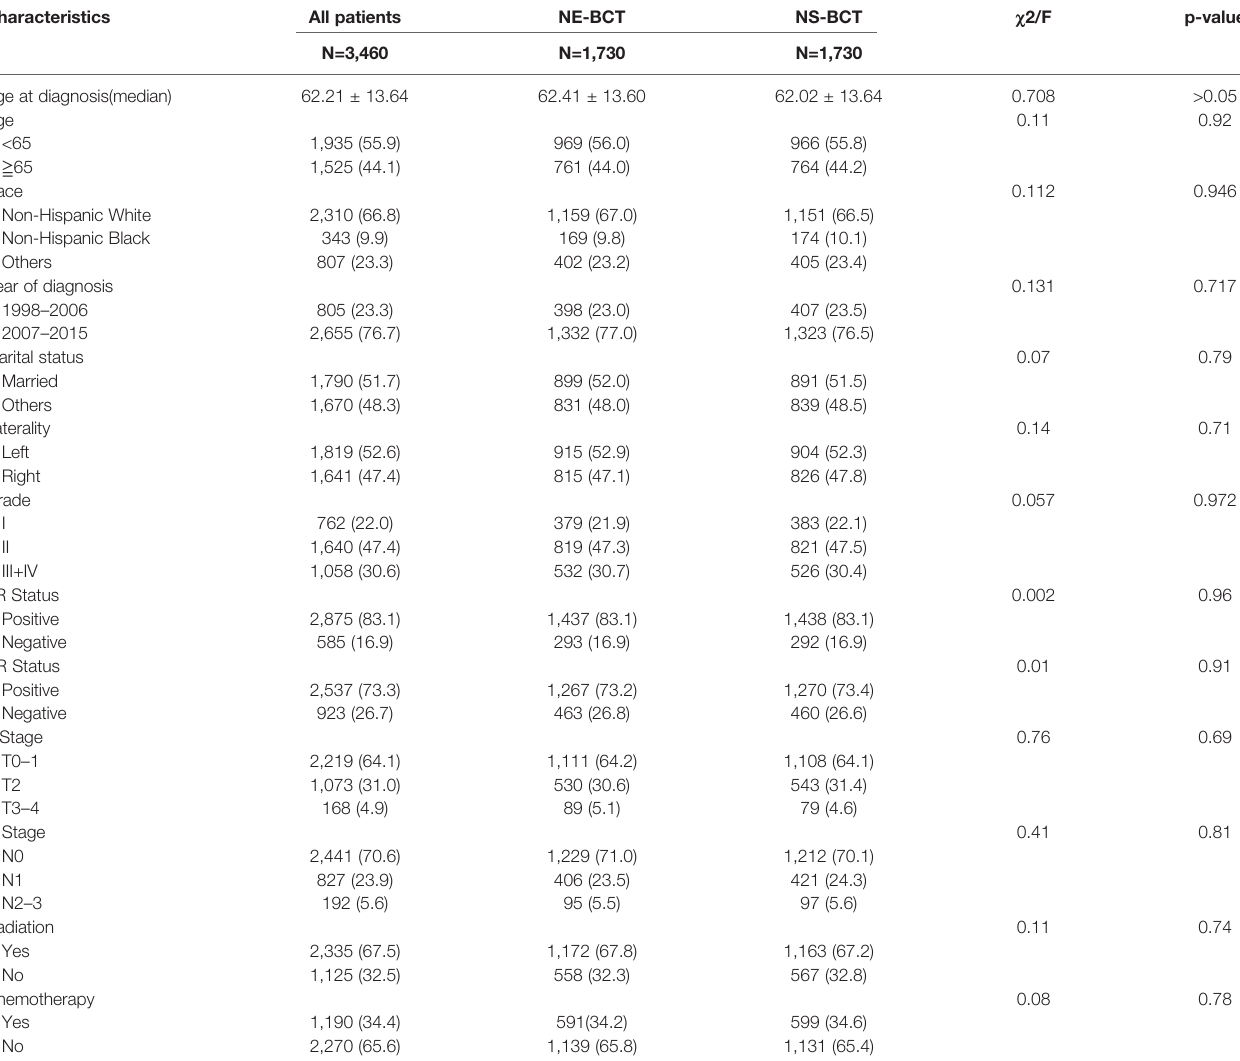
TABLE 1 | Patient clinical and pathological